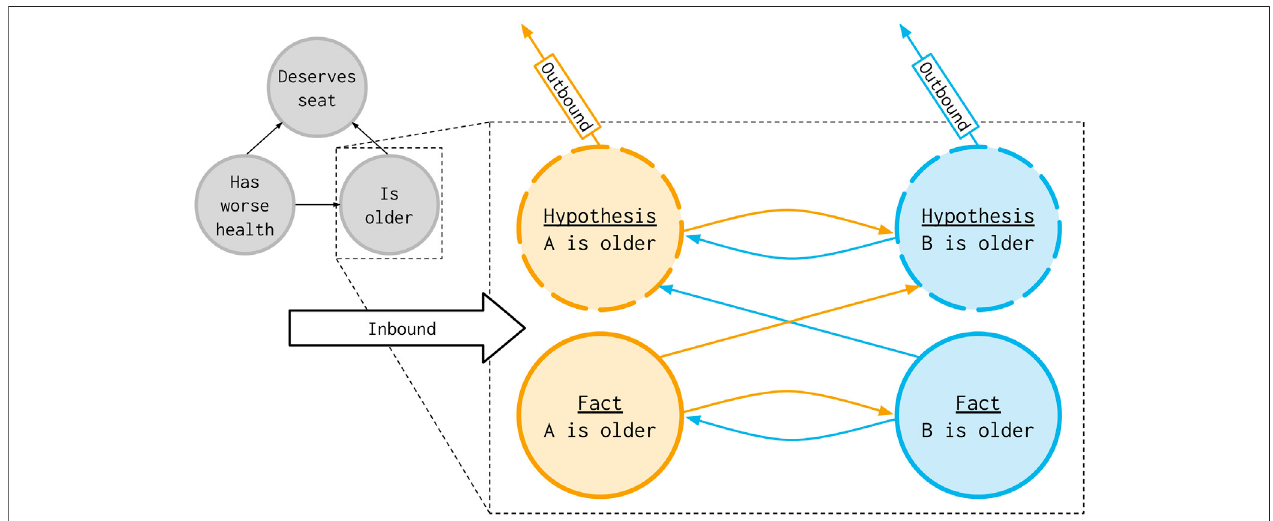
FIGURE 1 | Alteroceptive cultures transform the arguments of a given culture (grey) into hypotheses (dashed nodes) and veri fi ed-facts (solid nodes). Shown here from Example 3.1, argument a , “ Is older, ” is transformed into the respective nodes for the orange opponent, a op H and a or F , and the blue proponent, a pr H and a pr F . The inbound attack (left) from “ Has worse health ” attacks all four nodes and the outbound attacks (top) attack “ Deserves seat ” from the